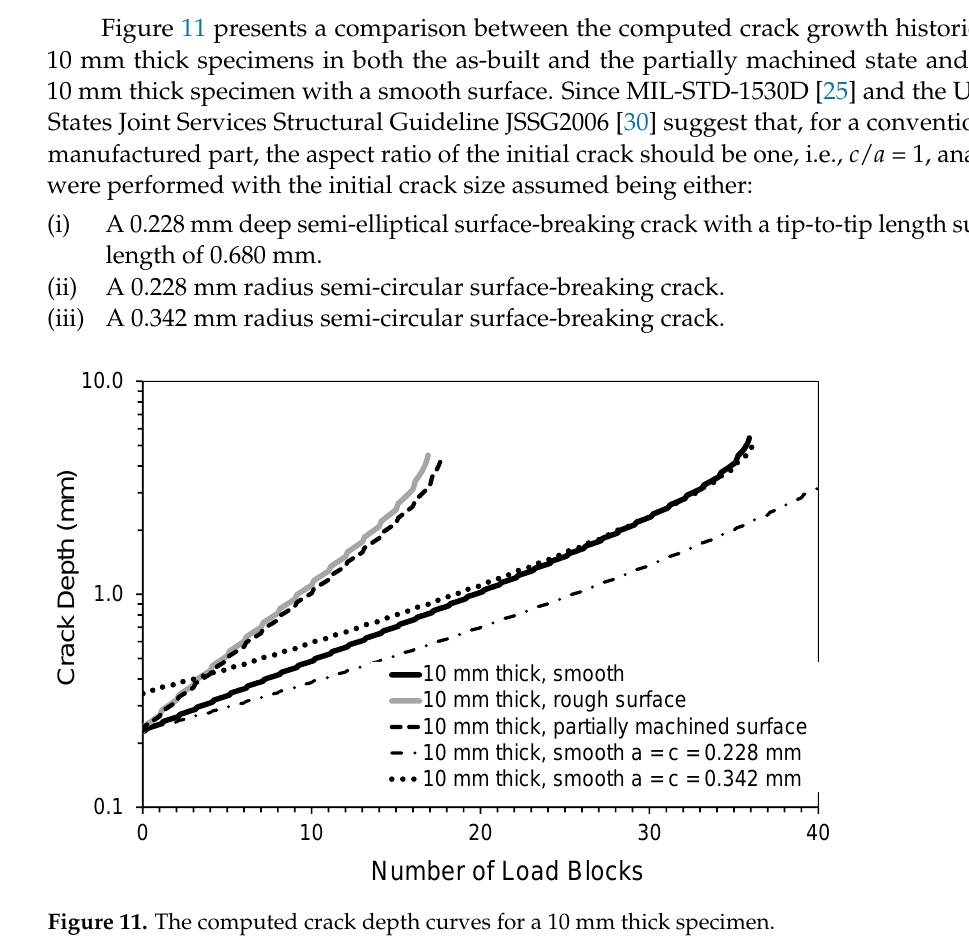
Figure 10. The fine mesh, 609,768 ten nodded iso-parametric tetrahedral elements and 876,866 nodes.